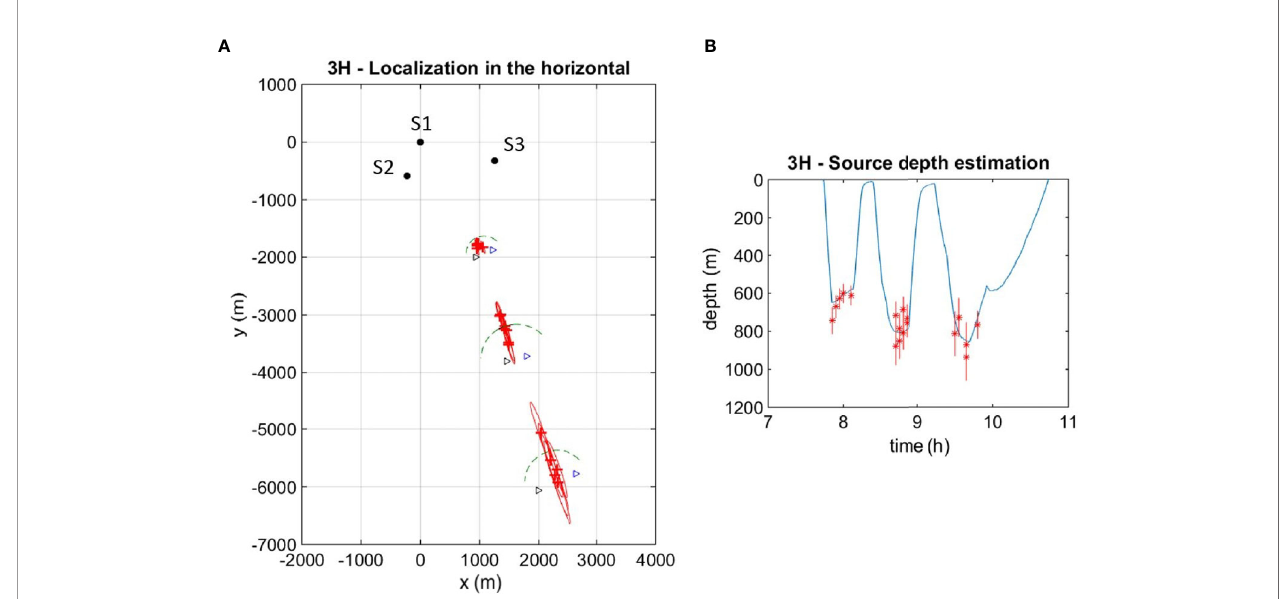
FIGURE 14 | Controlled localization experiment on 27 August 2021. (A) Localization results in the horizontal (red). The black/blue triangles denote the vessel GPS fi xes at the start/end of each station, respectively, whereas the green dashed arcs indicate the area behind the vessel within which the pinger is expected to be. (B) Localization results in the vertical (red). The actual pinger depth as function of time is represented by the solid blue